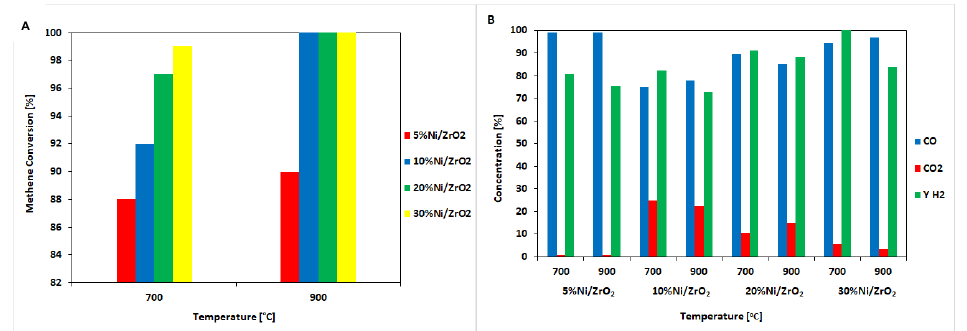
Figure 1. Catalytic activity results obtained for monometallic Ni/ZrO 2 catalysts in the oxy-steam reforming of methane expressed as methane conversion, and the selectivity of the CO and CO 2 and hydrogen yield formed during the process. ( A ) Methane conversion. ( B ) The selectivity towards CO and CO 2 and hydrogen yield.